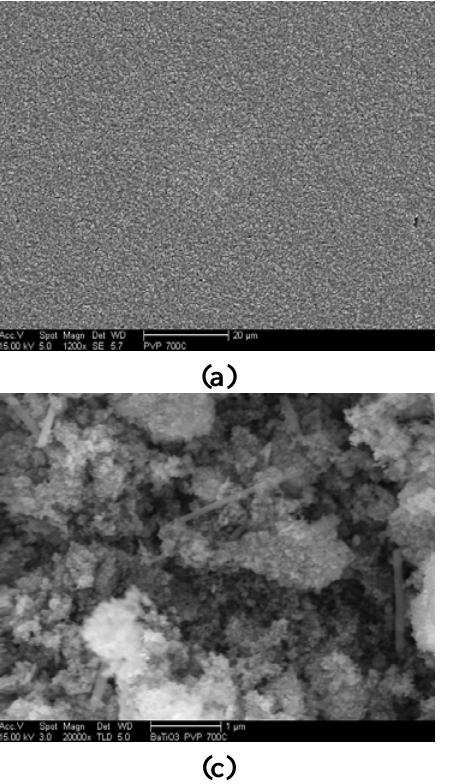
:Eu 3+ of films (a), (b) and powders (c), (d) calcined at 700 °C. 3